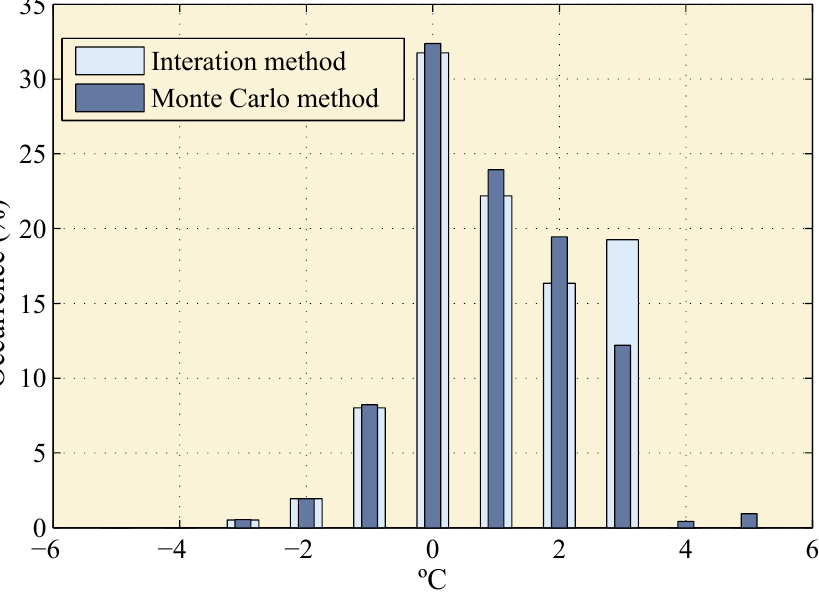
Figure 19. Differences between measured and estimated conductor